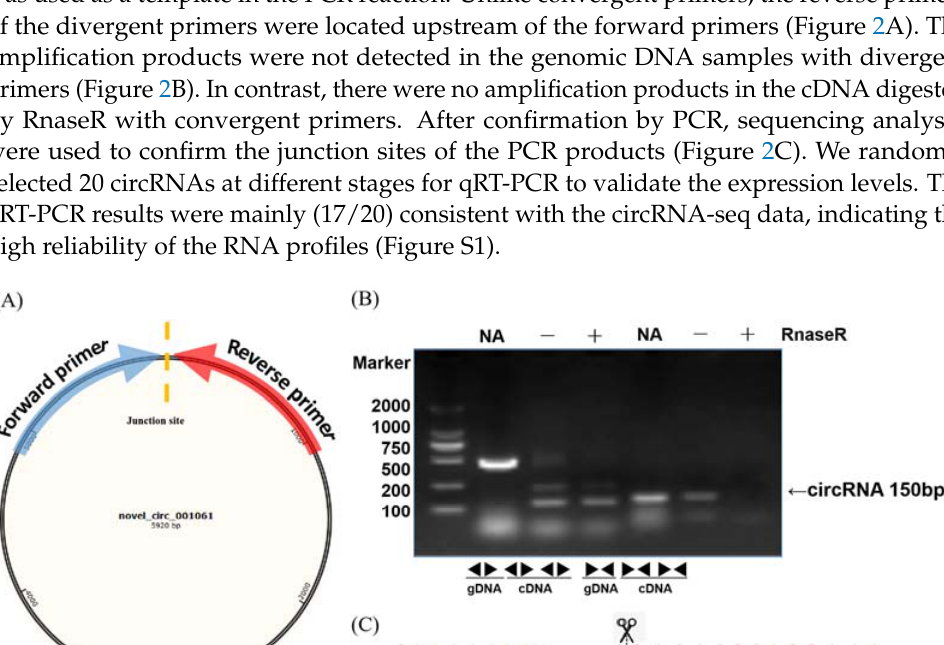
Figure 2. Validation examples of circRNA production. ( A ) Diagram of the circular RNA junction site. The arrow direction indicates the direction of the divergent primer design. ( B ) PCR reactions with divergent and convergent primers using different templates showing the production of novel_circ_001061 . ( C ) Sequencing confirmation of the junction site of novel_circ_001061 .